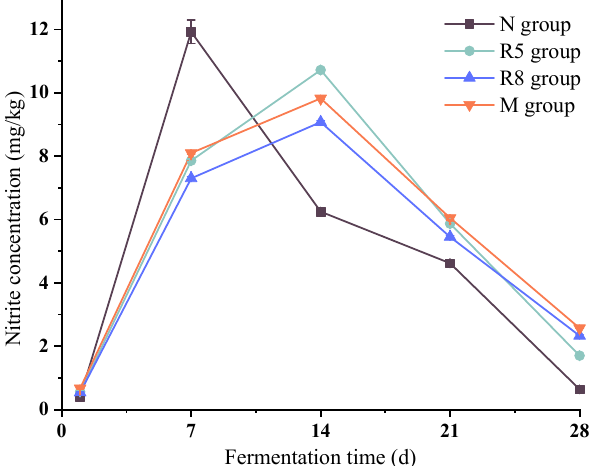
Figure 4. Changes in nitrite concentration in pickles during fermentation.